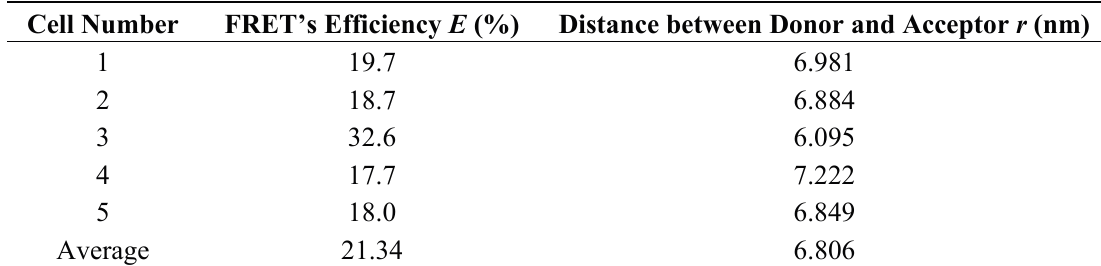
Table 1. Fluorescence resonance energy transfer (FRET) efficiency and distance of the region of interest (ROI) from the cells co-transfected with pECFP-C1- SelP' and pEYFP-C1- Tub determined by sensitized emission method.